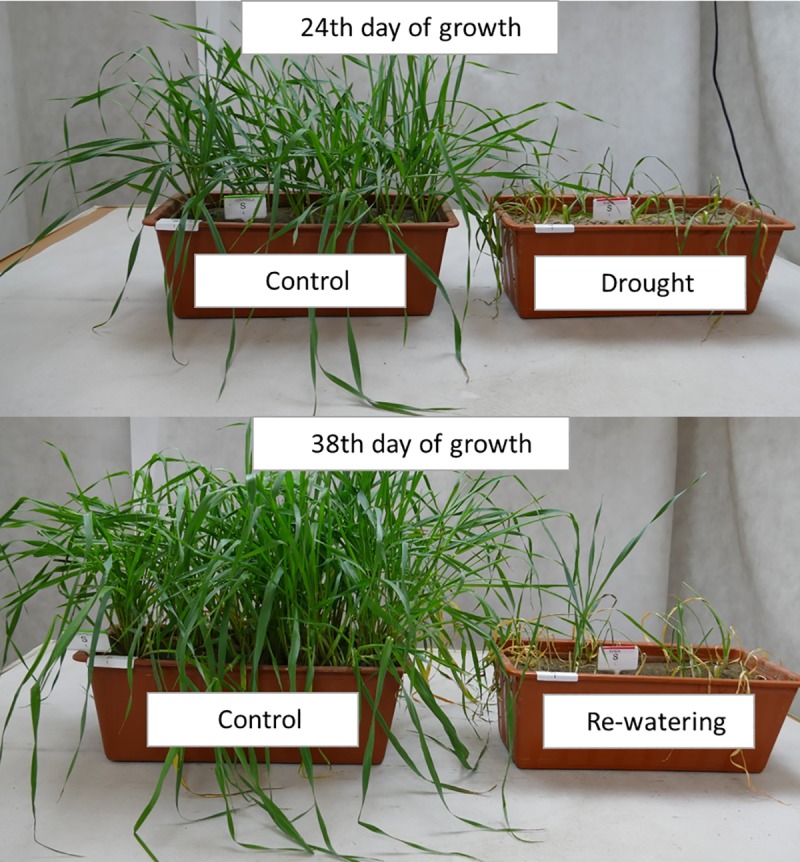
Phenotypes of ‘Sebastian’ seedlings during drought assay under control growth (CG) and after 14 days of drought stress (DS) on 24th DAS; under CG and after 14 days of re-watering (RW) on 38th DAS.